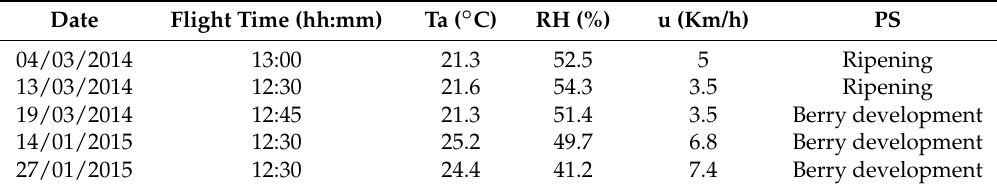
Table 2. Air temperature (Ta), relative humidity (RH), wind speed (u) and phenological stage (PS) at the time of unmanned aerial vehicle (UAV) overpass during the 2014–2015 growing season.